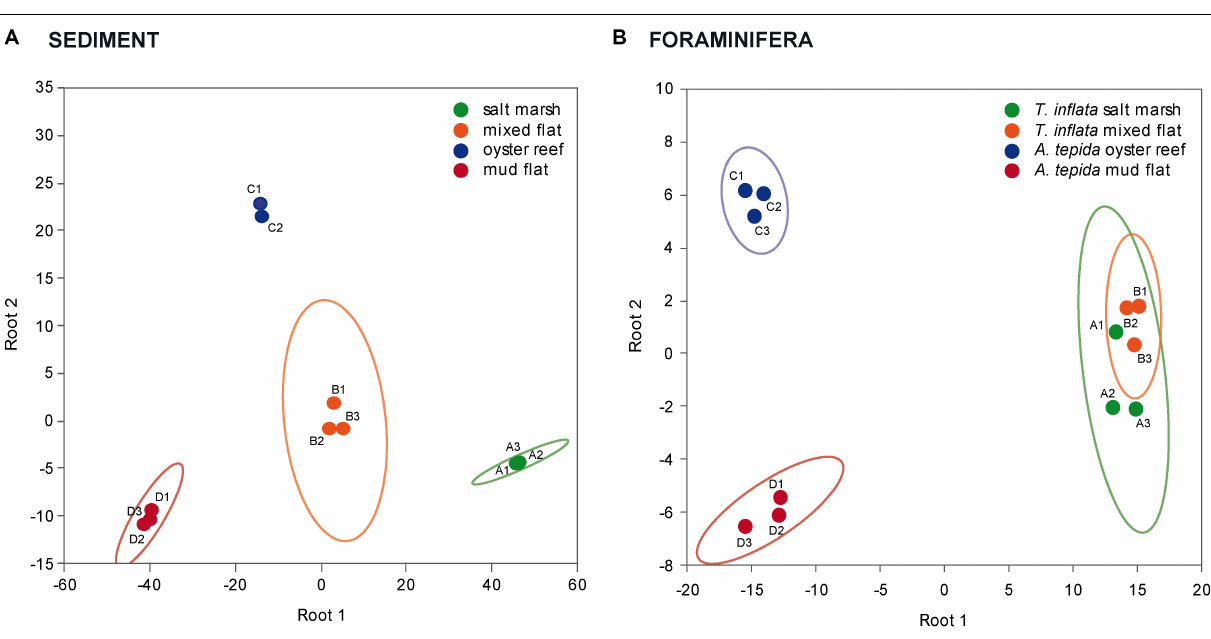
FIGURE 3 | Separation of the four habitats studied based on variations in sediment and foraminifera FAs. Discriminant function analysis (DFA) of (A) sediment FAs and (B) foraminifera FAs of Trochammina inflata and Ammonia tepida in salt marsh (green; replicate A1-3), mixed flat (orange; replicate B1-3), oyster reef (blue; replicate C1-3) and mud flat (red; replicate D1-3); ellipses represent confidence ranges at p <